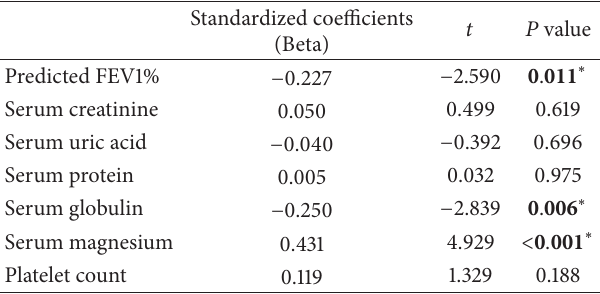
Table 2: Linear regression analysis showing factors affecting fre- quency of